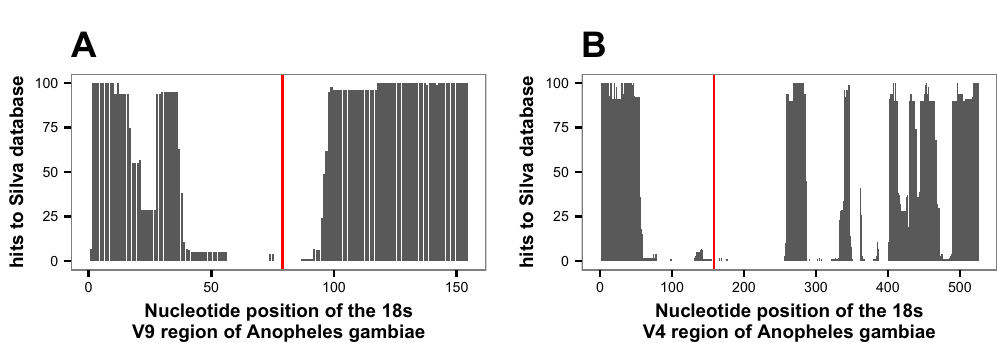
Figure 2. Identification of PNA oligonucleotide blocker candidates for the V9 region of Anopheles . In order to design PNA blockers specific to Anopheles , but allowing efficient amplification of other eukaryotic organisms, the Silva eukaryotic database was queried with mosquito candidate sequences to identify those with the smallest number of non-mosquito hits. ( A ) The full-length sequence of the V9 hypervariable region of A . gambiae was split in silico into all possible 17mers, and each 17mer was queried against the full length 18s rRNA gene sequences from the Silva 119 database for all non-mosquito eukaryotes. The number of matches was graphed (y-axis), limiting the representation to a maximum of 100 hits. The location of the selected current PNA blockers is indicated (red vertical line). ( B ) As in A, but for V4 region PNA oligonucleotide